Question: In a single sentence, describe what this figure presents.
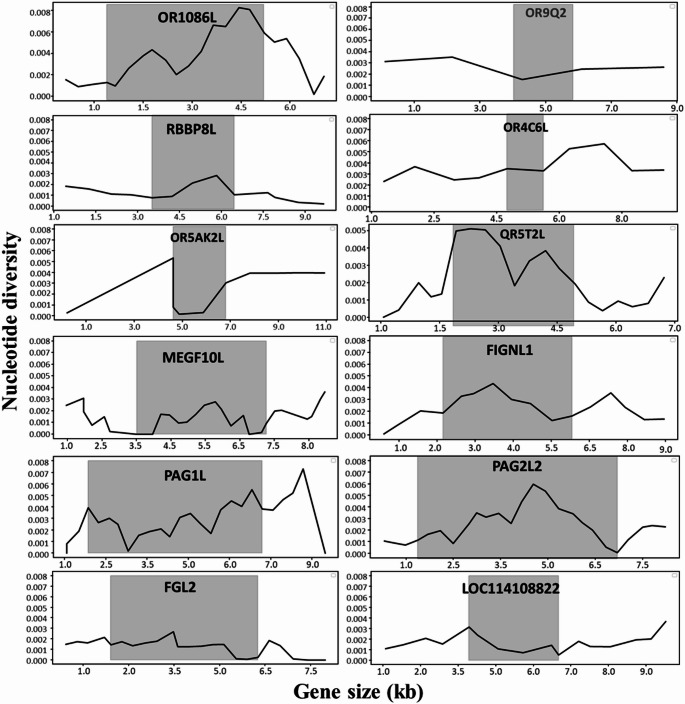
Answer: Nucleotide diversity of the genes identified in selective sweep analysis. X-axis represents the gene size in kb and Y-axis represents nucleotide diversity. Low nucleotide diversity values indicate strong selective sweeps where a beneficial allele has reduced diversity. Low nucleotide diversity score + low ZHP score indicate strong selective sweep. The shaded region in each graph shows the gene location, the unshaded regions show upstream and downstream regions. MEGF10L multiple epidermal growth factor-like domains protein 10, FIGNL1 fidgetin like 1, PAG1L pregnancy-associated glycoprotein 1-like, PAG2L pregnancy-associated glycoprotein 2-like, OR4C6L olfactory receptor 4C6-like, OR1086L olfactory receptor 1086-like, OR5AK2L olfactory receptor 5AK2-like, OR5T2L olfactory receptor 5T2-like, OR9Q2 olfactory receptor 9Q2, RBBP8L retinoblastoma binding protein 8-like, FGL2 Fibrinogen-like protein 2